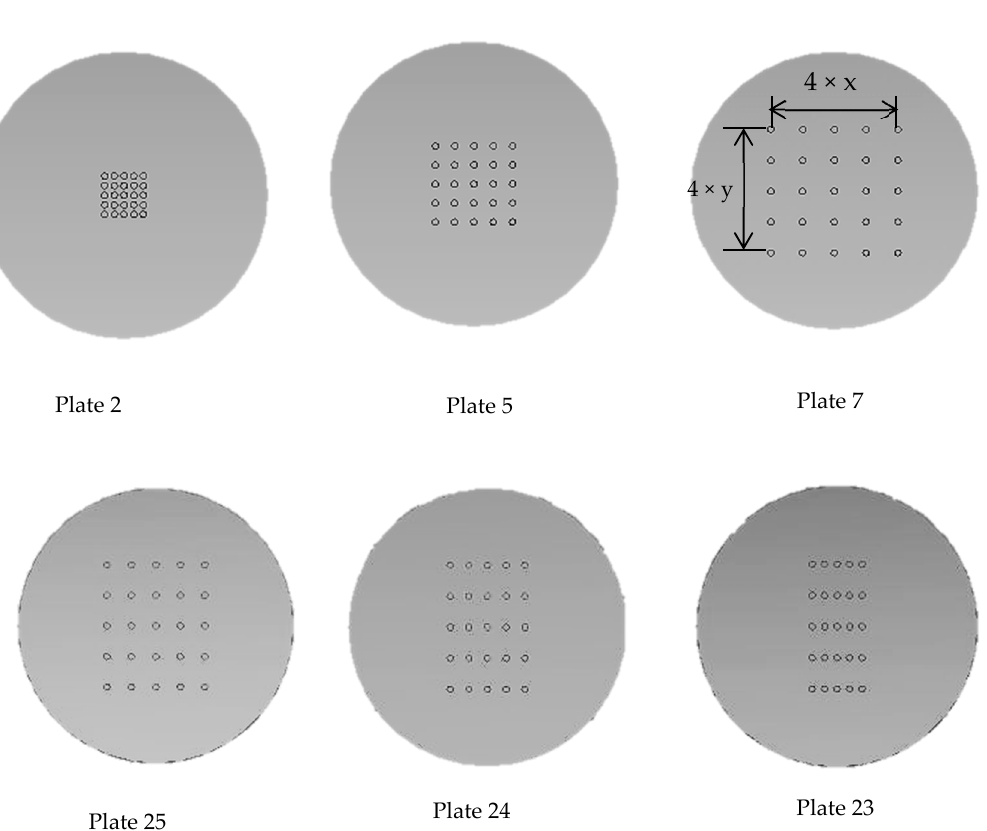
Figure 3. An impedance tube configured with two microphones.